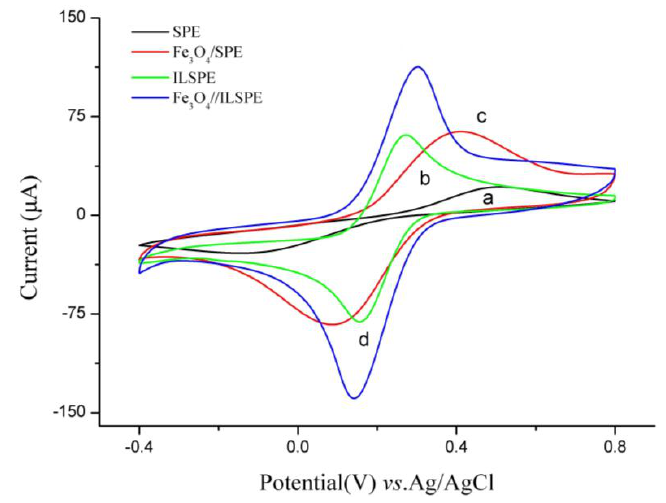
Figure 2. Cyclic voltammograms of different electrodes in 5 mM/L [Fe(CN) 6 ] 3−/4− and 0.1 mol/L KCl, ( a ) SPE, ( b ) Fe 3 O 4 /SPE, ( c ) ILSPE, ( d ) Fe 3 O 4 /ILSPE. Scan rate: 50 mV/s.